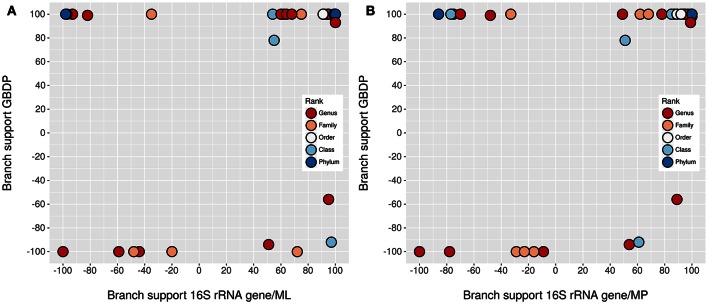
Comparison of branch support. Shown are the negative or positive branch support values for each taxon inferred from whole genomes with GBDP in comparison to those inferred from 16S rRNA gene sequences with ML (A) and MP (B). The colors indicate the taxonomic rank. The upper right corner contains the taxa significantly supported by all methods, the lower left corner those significantly opposed by all methods. The other two corners, which would indicate a significant conflict between the methods, are empty. Jitter was used to avoid overplotting.